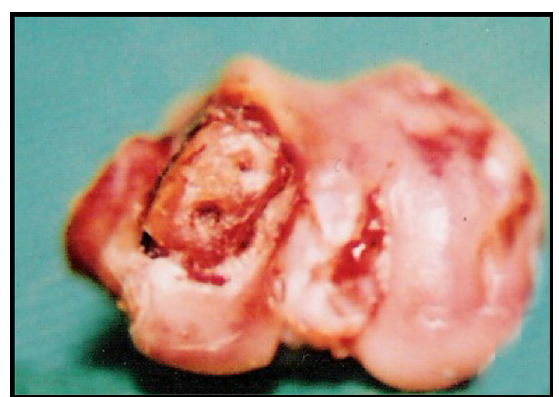
FIGURE 2 - Fragment osteochondral fastened at her bed with the resorcina adhesive.